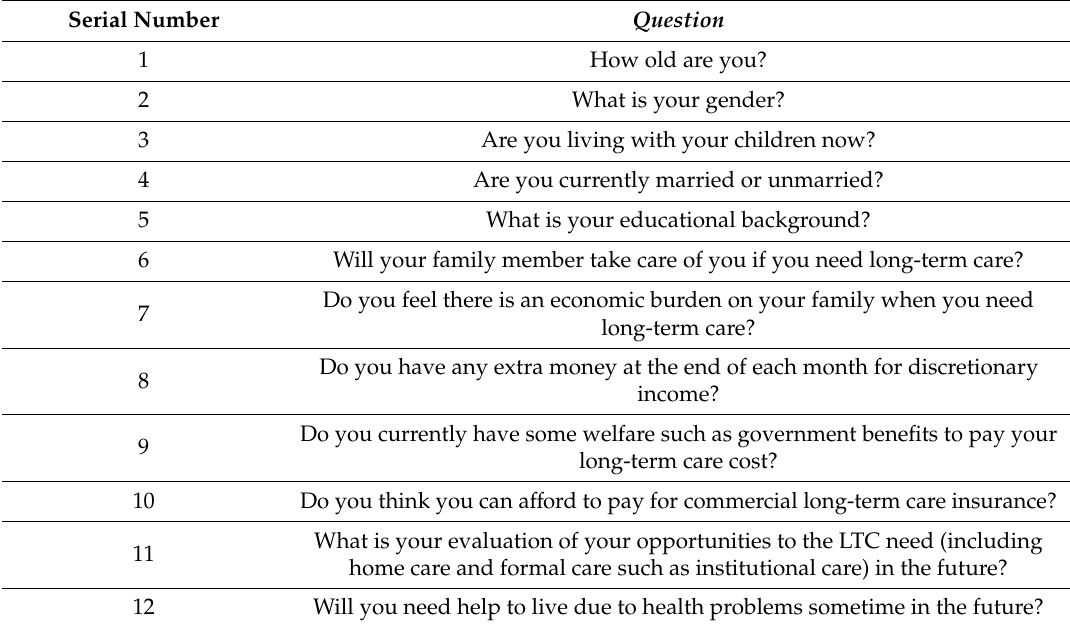
Table A1. Simplified questionnaire